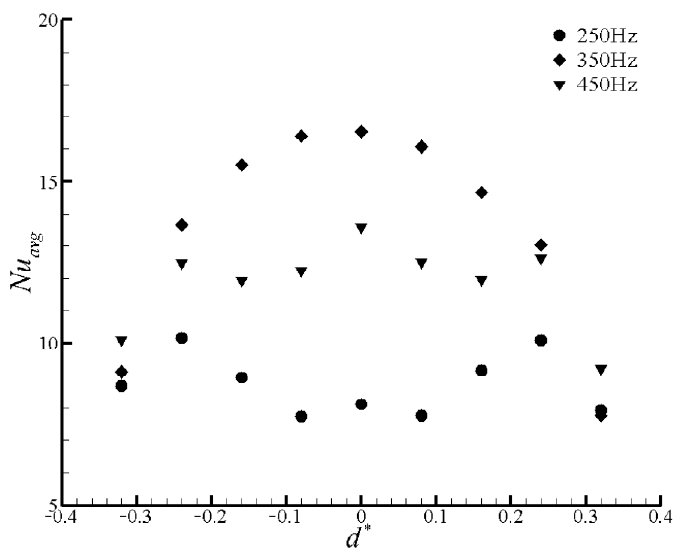
Figure 7. Nu avg variations with the driving frequency and the slider location.